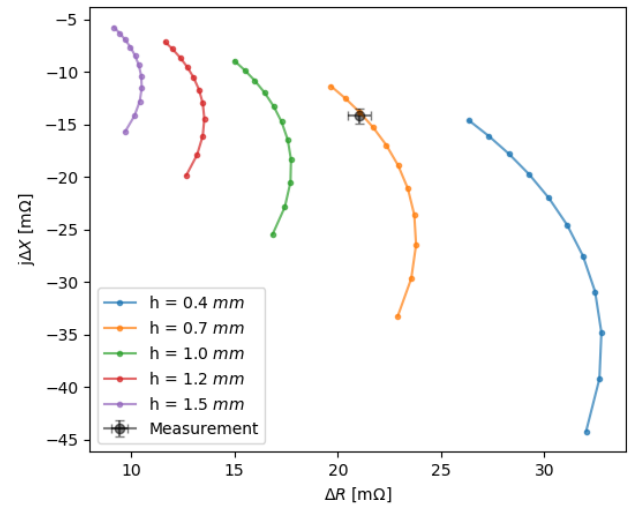
Figure 12. Response of the coil on a graphite substrate for the maximum acquisition frequency of f max = 2 MHz with simulated responses for different lift-off parameters h and bulk resistivity between 5000 n Ω m and 15,000 n Ω m. The intersection of the curves with the data-point gives the actual lift-off of the measurement, i.e., h = 0.7